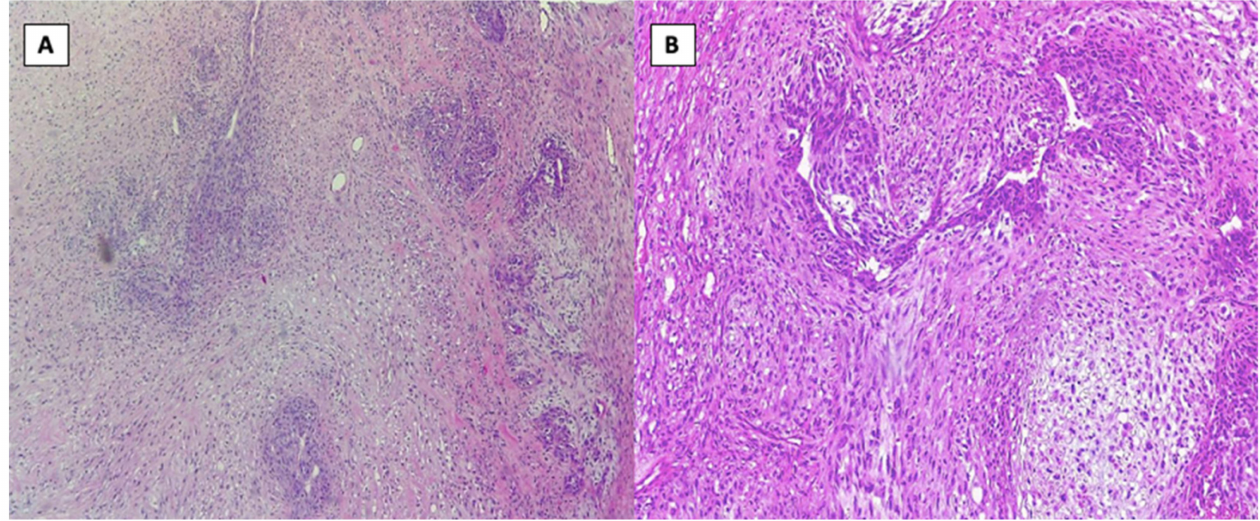
Figure 1. Histopathology images from the biopsy, H&E stain: ( A )—20 × and ( B )—40 × resolution. A month later, the patient returned with cardiac tamponade, and the emergency CT examination showed a sternocostal tumor of a large size (6/9 cm) and left pleurisy, as seen in Figure